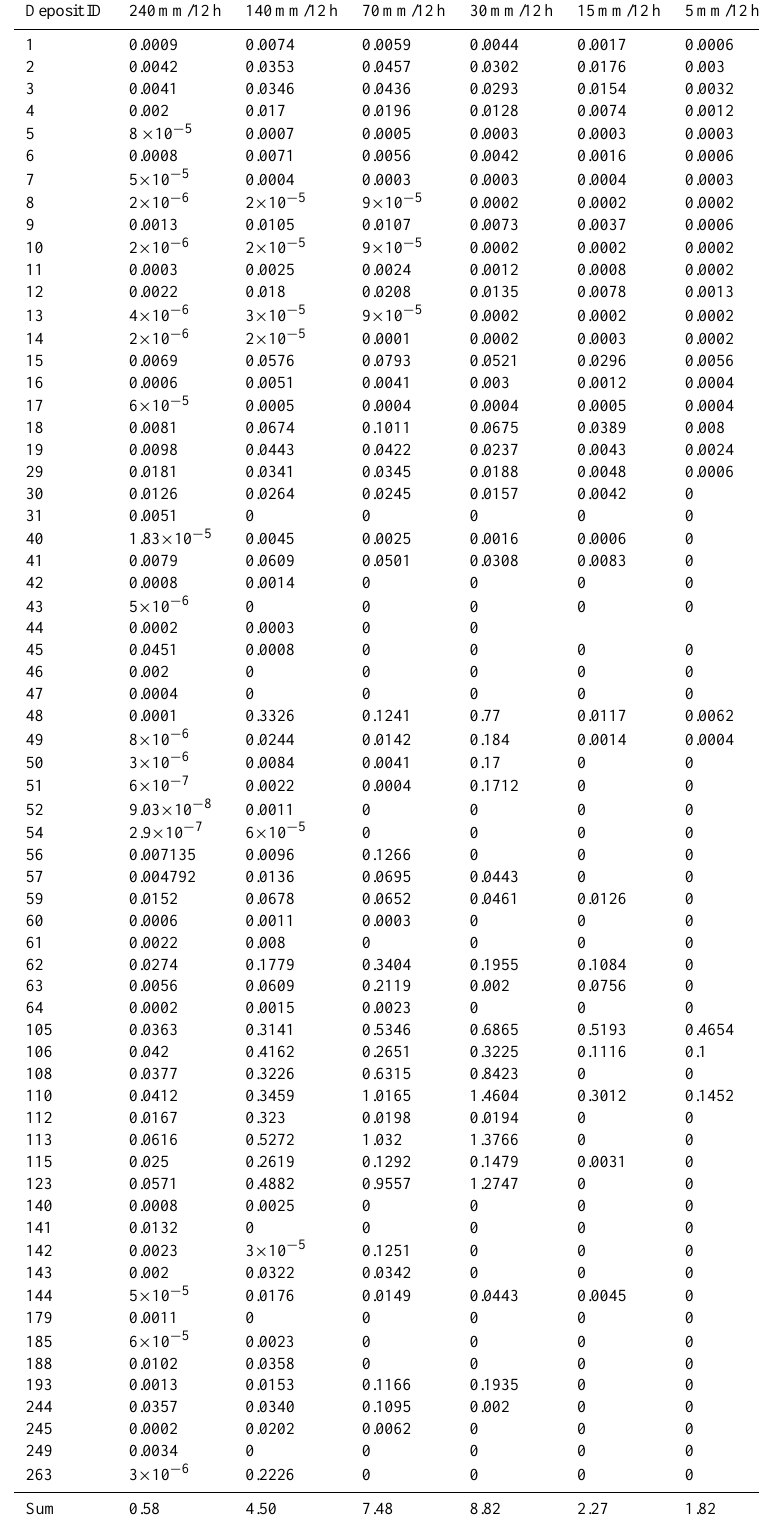
Table 3. Results of annual societal risk ( R ( LOL ) ) for fatal loose deposit failures under six rainfall